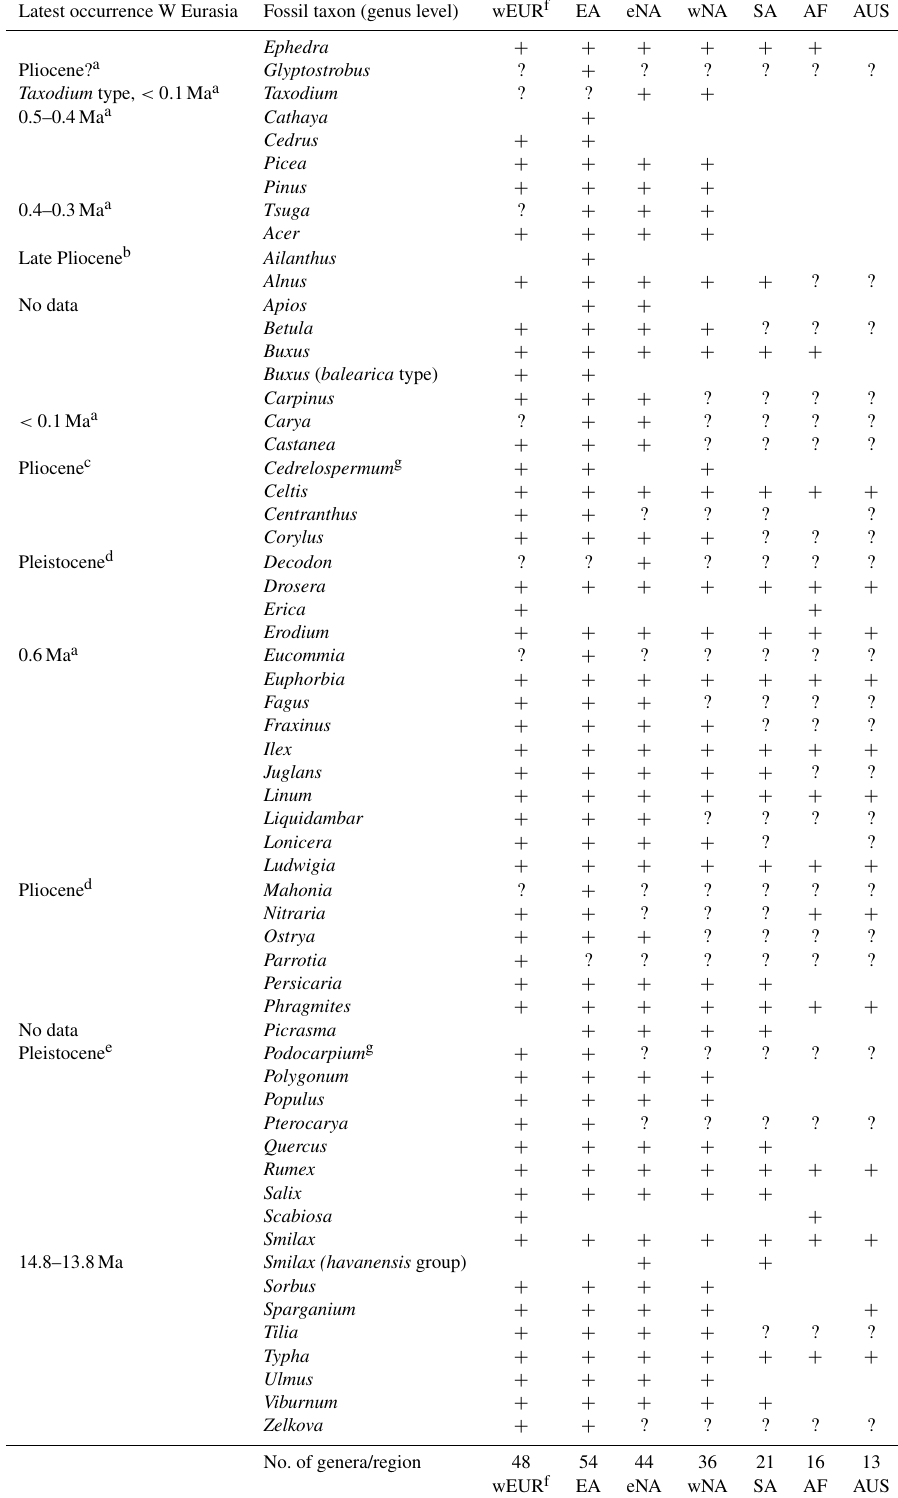
Table 1. Genus-level biogeographic affinities of fossil taxa of the Yata˘gan Basin